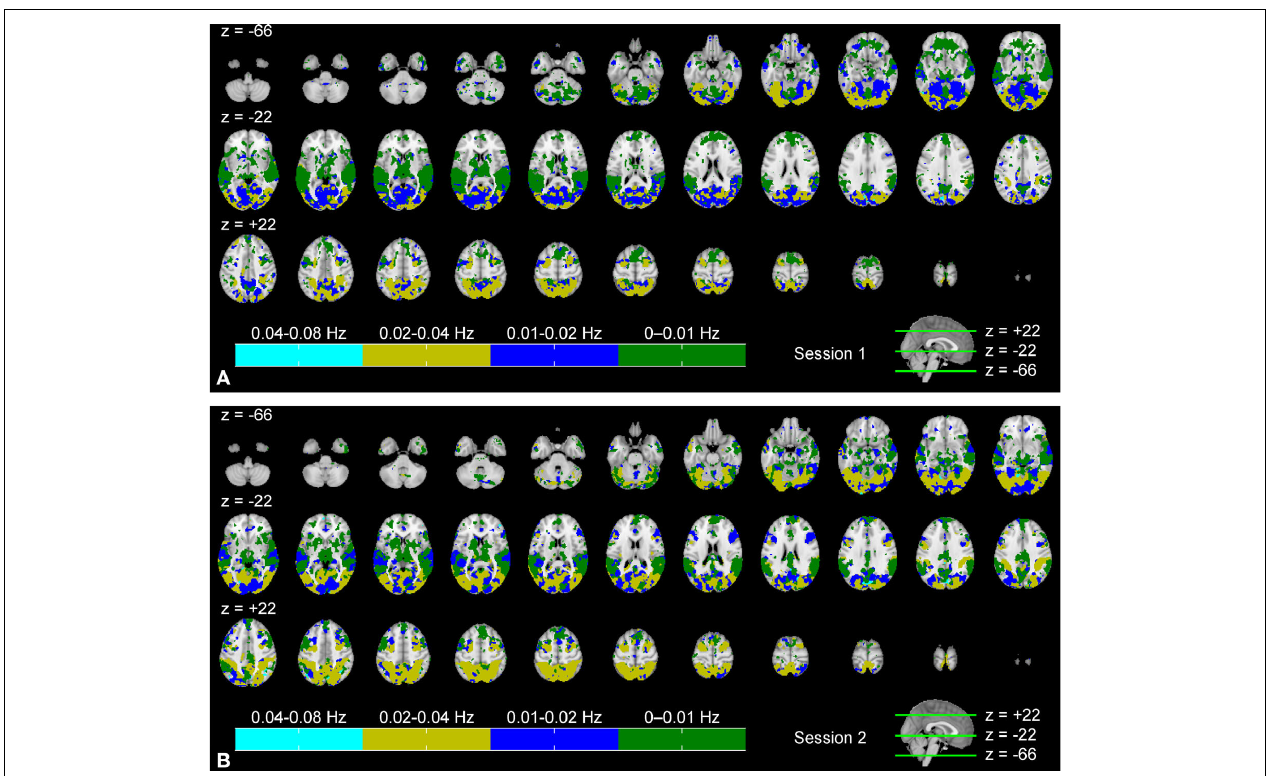
FIGURE 4 | Frequency ranges showing maximum ISC across: (A) the fi rst scanning session, and (B) the second scanning session. From top left to bottom right, axial slices are shown from z = − 66 to 62 mm (in MNI-coordinates)